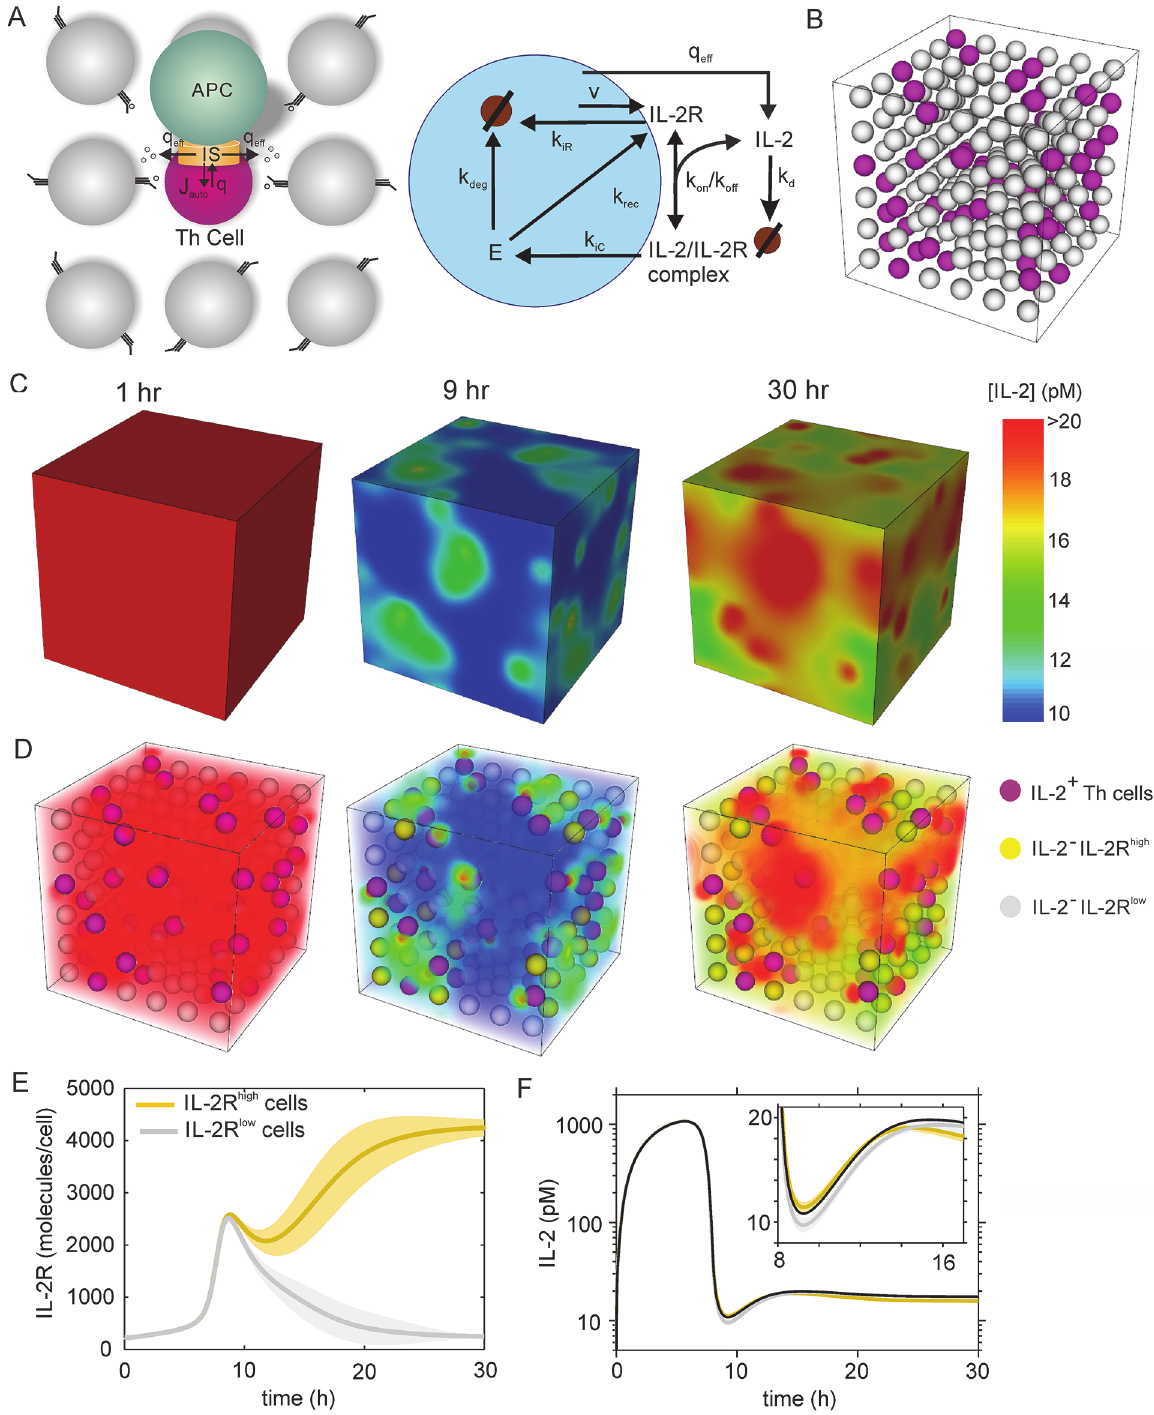
Fig 3. Spatiotemporal cytokine dynamics of an in silico Th cell population. (A) Model scheme: (left panel) A fraction of Th cells (about 25%) releases cytokine molecules into the immunological synapse with rate q. Most of these molecules bind to the polarized cytokine receptors on the cytokine secreting cell (see Fig 2), a smaller fraction (about 20%) escapes the synapse and is considered as effective, polarized secretion rate q eff . (right panel) Intracellular receptor dynamics include receptor expression (rate v), binding of cytokine molecules (k on , k off ), internalization of free and bound cytokine receptor (k iR , k iC ), receptor recycling (k rec ) and receptor degradation (k deg ). Further, IL-2 degradation with rate k d is considered. (B) Setup of the simulation of a T cell population in three dimensions. The cell-to-cell distance (shortest distance between cell surfaces) and cell radius are both 5 μ m. The simulations included 216 cells, of which 54 were randomly chosen as secretory (marked pink). Only T cells are included in the simulation, APCs are assumed to fill the region between T cells,